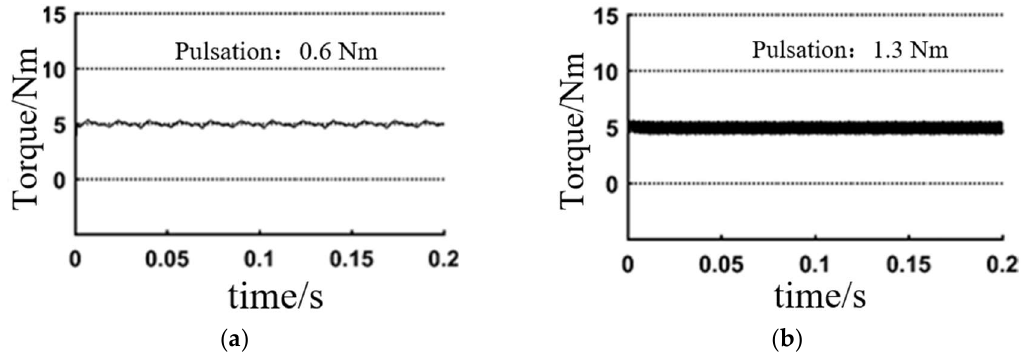
Figure 5. Simulation results with different speed. ( a ) 100 rpm; ( b ) 2000 rpm.